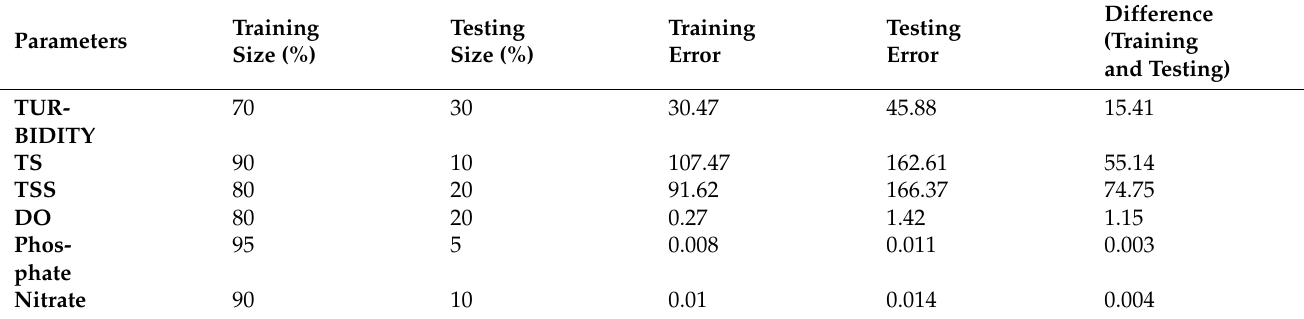
Table 3. Training and testing best-fit size displaying the least difference.